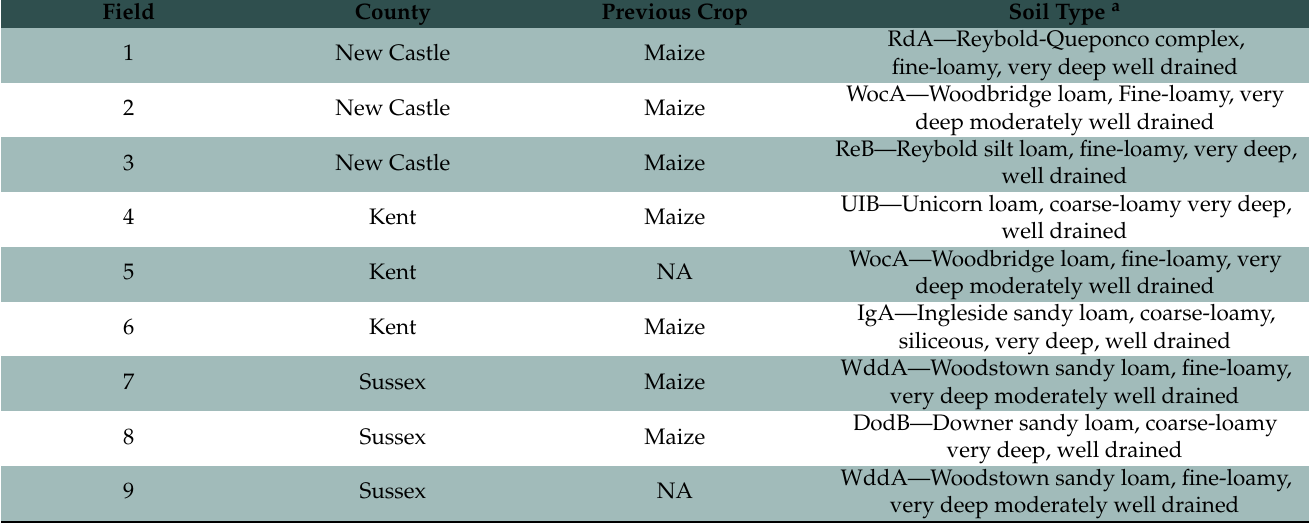
Table 1. Description of the field